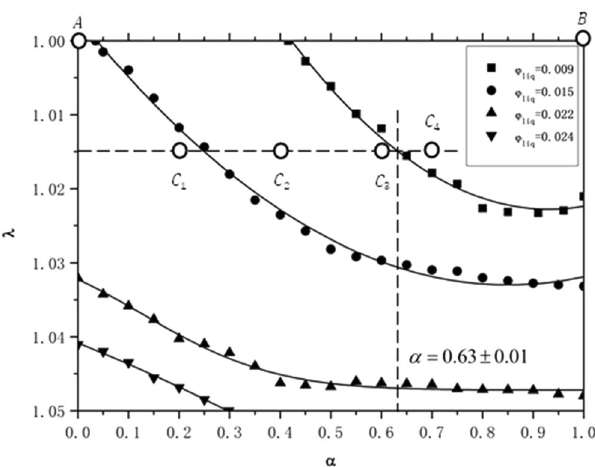
Figure 5. Critical points in α and λ fitted into four curves for four fixed ϕ liq in a phase diagram, showing phase transition from honeycomb-like to Tóth-like structures. Six points ( A , B , C 1 , C 2 , C 3 , C 4 ), correspond to six structures as shown in Table 2. There are no curves for Tóth-like converting to honeycomb-like, since such transitions were not